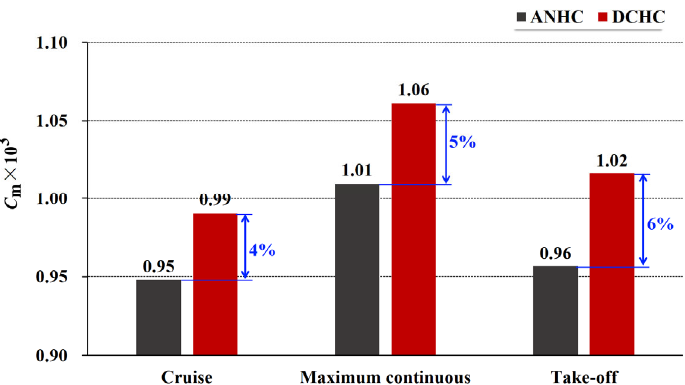
Figure 32. Moment coefficient of rotating disk surface under ANHC and DCHC.